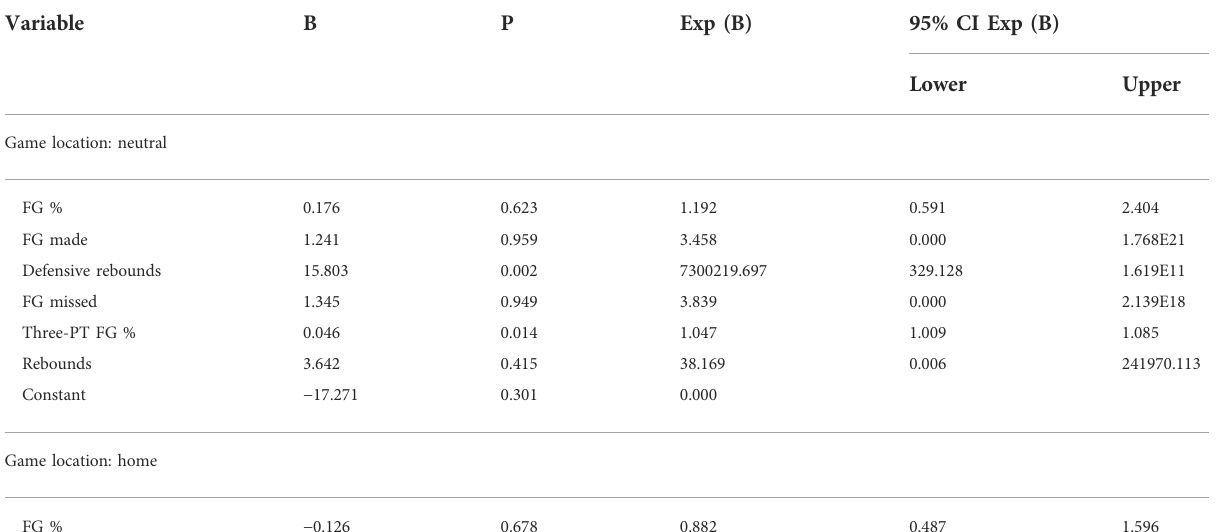
TABLE 6 Binary logistic regression